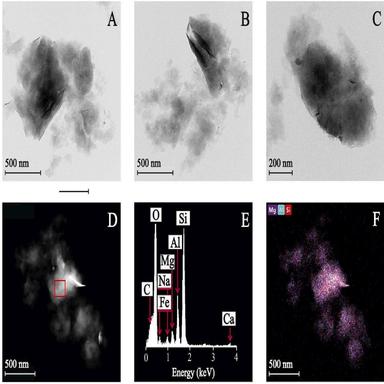
UHR-TEM microphotographs (a-d), EDX spectrum (e) and elemental maps (f) of Mt. EDX spectrum was performed in red squares. (For interpretation of the references to colour in this figure legend, the reader is referred to the web version of this article.)